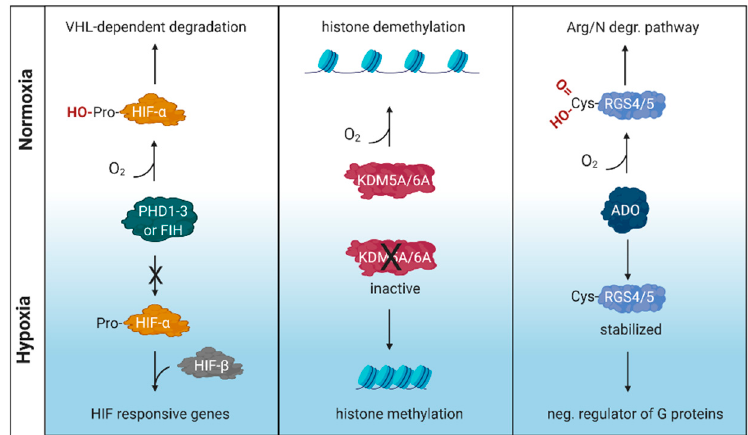
Figure 1. Schematic illustration of oxygen sensing mechanisms. These include the prolyl hydroxylase domain (PHD) / factor inhibiting HIF (FIH)-hypoxia inducible factor (HIF) pathway, lysine-specific demethylase (KDM) 5A and KDM6A pathways and the cysteamine (2-aminoethanethiol) dioxygenase (ADO) pathway. RGS, regulator of G protein signaling; VHL, von Hippel–Lindau tumor suppressor gene. Created with BioRender.com.